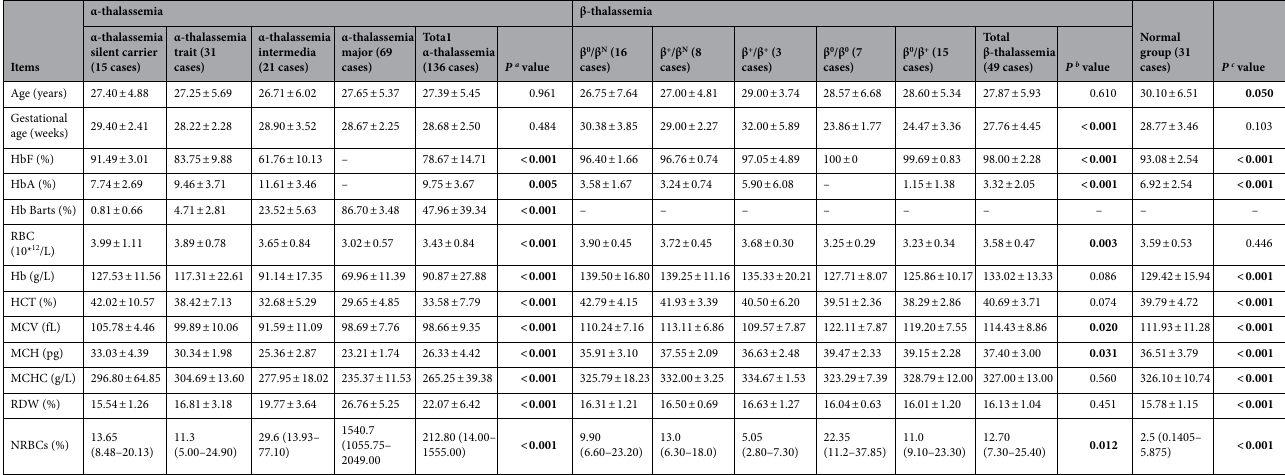
Table 3. Distribution and Comparisons of hematological parameters among fetuses of different genotypes. P a : Comparison among 4 α-thalassemia subgroups using ANOVA test for all the hematological parameters except for the NRBCs using Kruskal–Wallis test; P b : comparison among 5 β-thalassemia subgroups using ANOVA test for all the hematological parameters except for the NRBCs using Kruskal–Wallis test; P c : comparison among all the α-thalassemia cases, all the β-thalassemia cases and normal group using ANOVA test for all the hematological parameters except for the NRBCs using Kruskal–Wallis test. Significant differences ( P < 0.05) are indicated in bold.